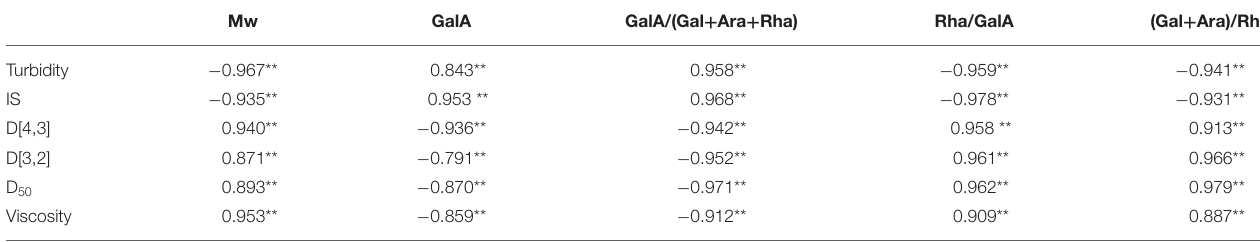
TABLE 3 | Correlation matrix between stability and pectin characteristics in NFC orange juice. Mw GalA GalA/(Gal + Ara + Rha) Rha/GalA (Gal + Ara)/Rha Turbidity − 0.967** 0.843** 0.958** − 0.959** − 0.941** IS − 0.935** 0.953 ** 0.968** − 0.978** − 0.931** D[4,3] 0.940** − 0.936** − 0.942** 0.958 ** 0.913**